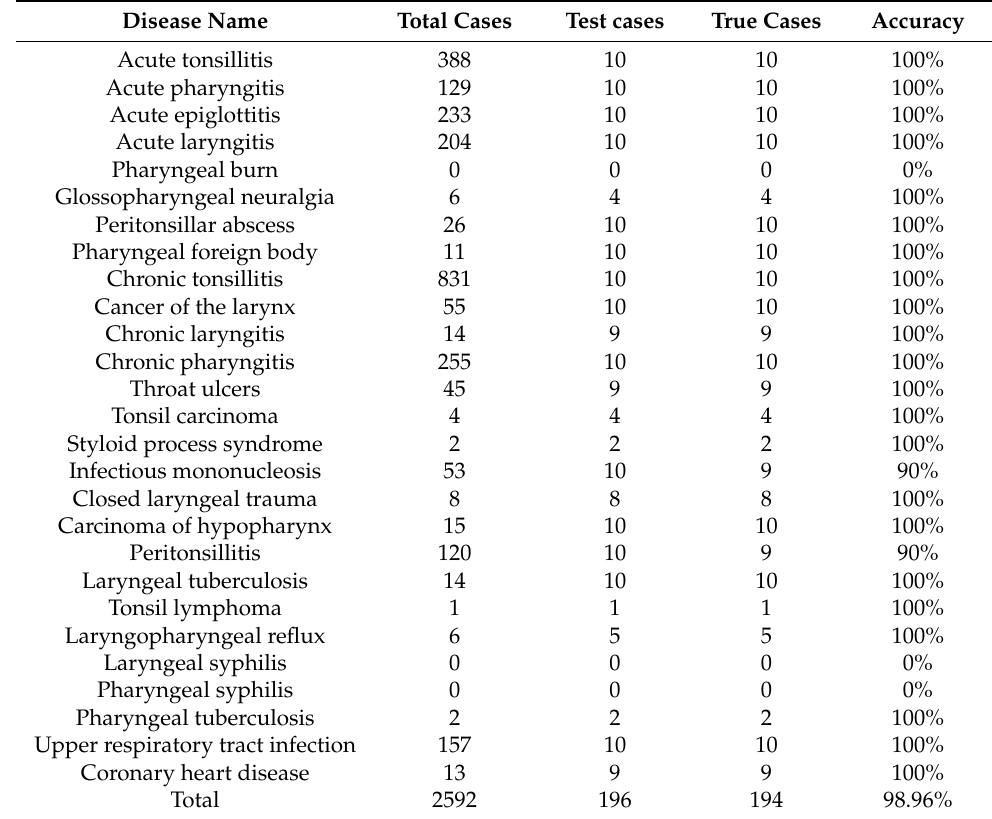
Table 4. The third-party test of the model in Suining Central